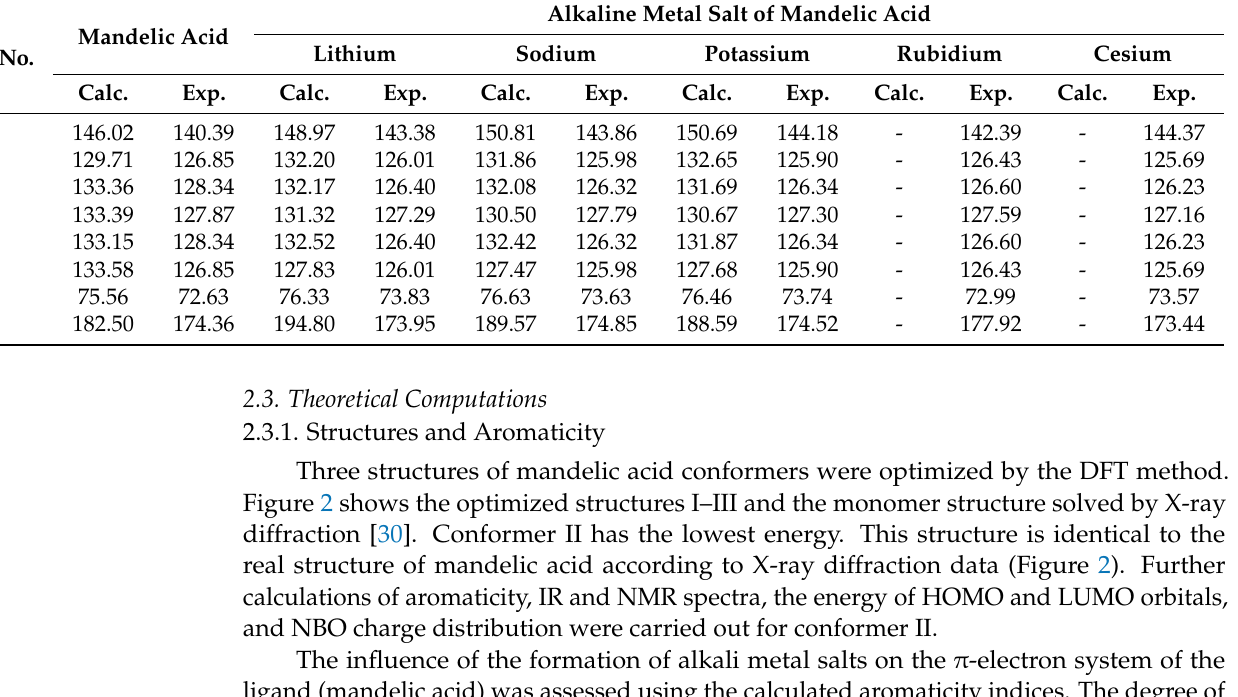
Table 3. 13 C chemical shifts for mandelic acid and its alkali metal salts (in experimental 13 C NMR spectra and theoretically calculated using